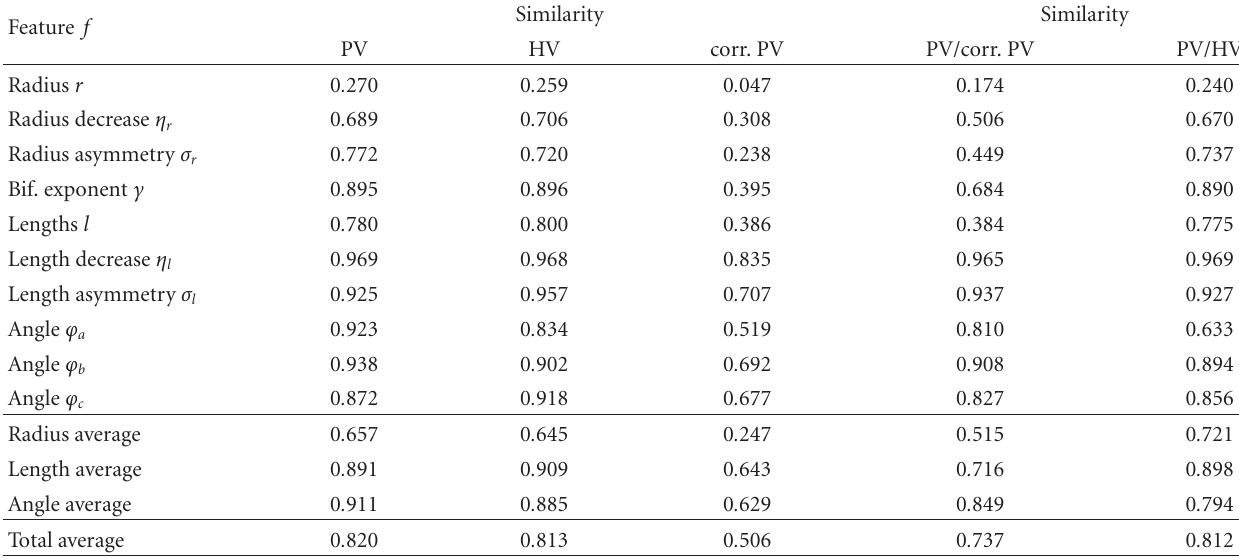
Figure 3: Overall histograms of the bifurcation exponents γ for our clinical PV (a), HV(b), and corrosion cast PV (c) data sets for di ff erent Strahler ∗ orders. Table 3: For di ff erent geometric features, the table lists the one-population similarity within the human clinical PV, HV, and corrosion cast PV data sets. Moreover, the two-population similarity between the clinical and corrosion cast PV as well as the clinical PV and HV data sets is listed. Unlike for the individual features, the numerical values of the averages in the one- and two-population cases cannot be compared due to the di ff erent averaging formulas (7) and